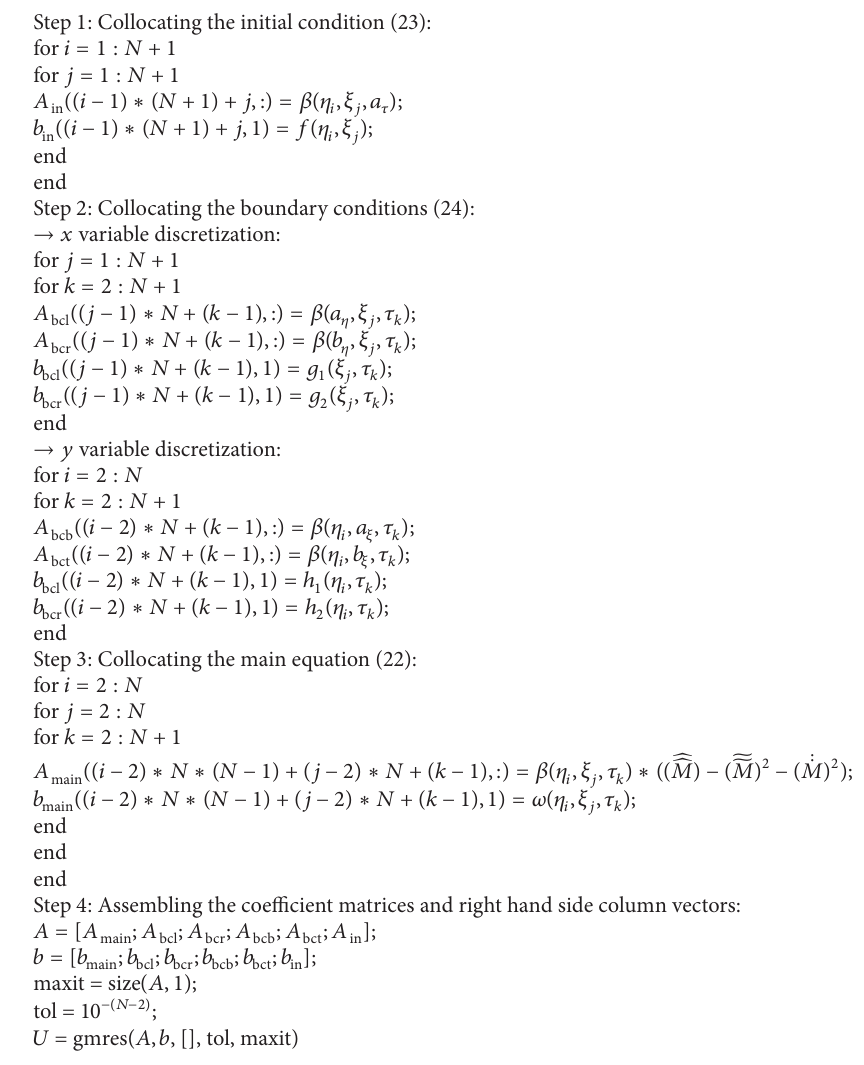
Algorithm 3: Implementation of BCM for solving